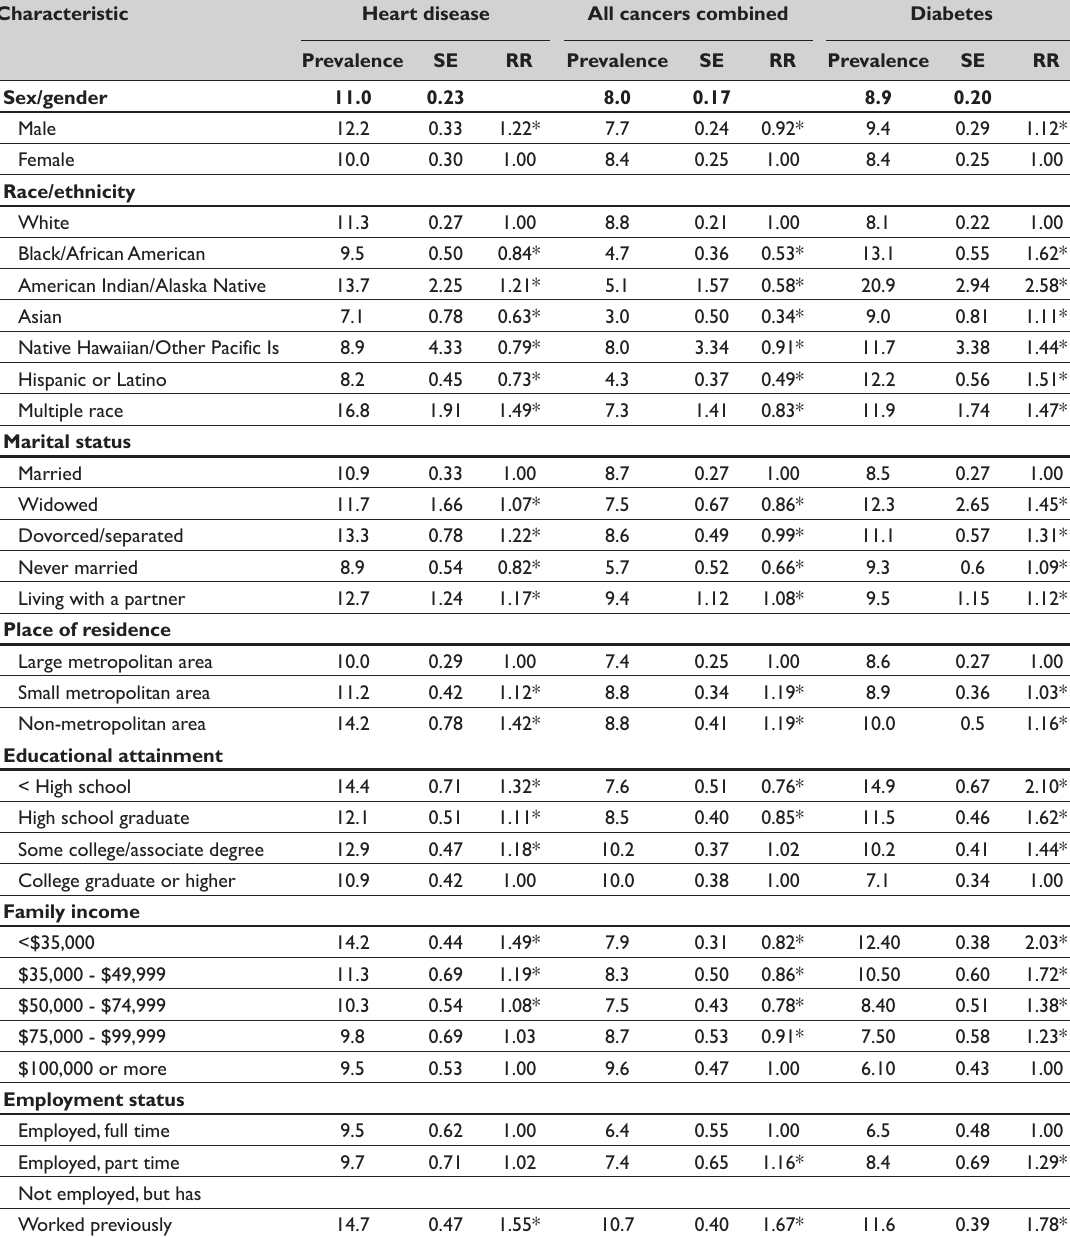
Table 2: Age-adjusted chronic disease prevalence (%) among US population aged ≥ 25 years by sociodemographic characteristics: 2015 National Health Interview Survey